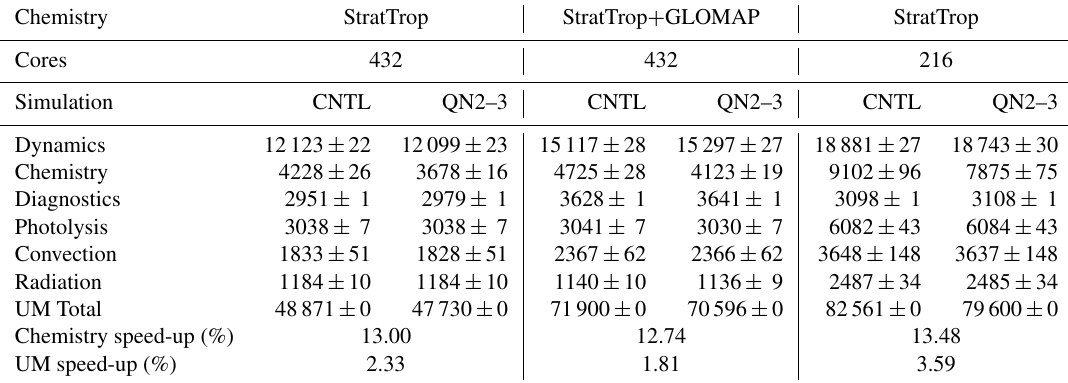
Table 5. Average wall-clock time in seconds ( ± 2 standard error) across all processors used for various UM components comparing the CNTL and QN2–3 methods. All are from 1-year simulations performed on a Cray